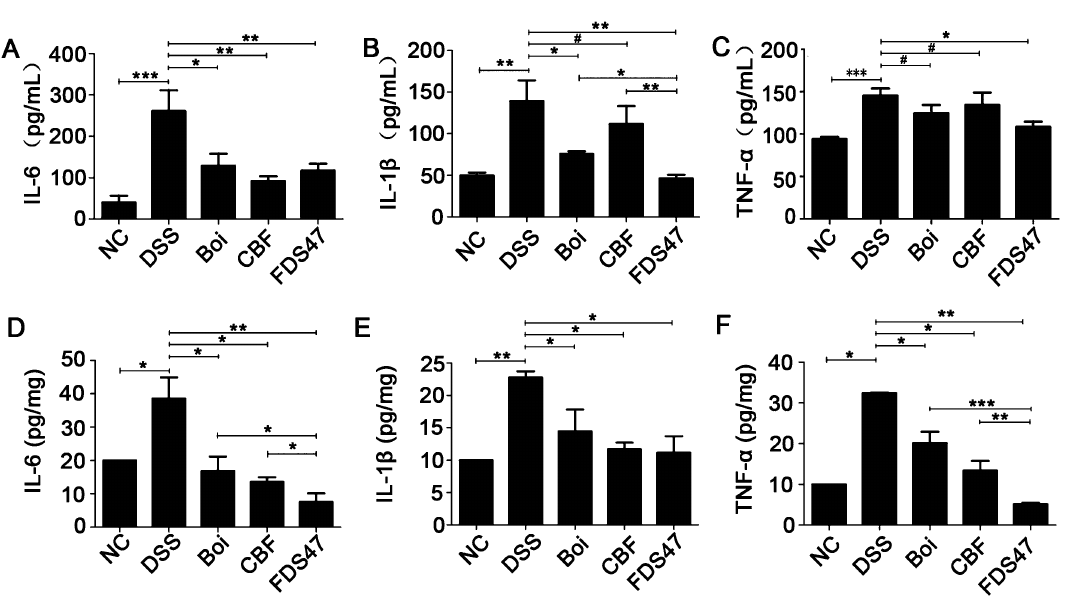
Figure 6. Effects of Boi, CBF or FDS47 on the levels of inflammatory cytokines in mice. Boi (boiled), CBF (compound bacterium fluid) and FDS47 (fermented Danshen sequence 47). The levels of IL-6 ( A ), IL-1β ( B ) and TNF-α ( C ) in serum of DSS- induced UC mice were detected using ELISA Kits. The levels of IL-6 ( D ), IL-1β (E) and TNF-α (F) in the colonic homogenate of DSS-induced UC mice were detected using ELISA Kits. All groups (NC, Boi., CBF, FDS47) were statistically analyzed with the DSS group. The FDS47 group and other groups (Boi., CBF) were statistically analyzed from group to group. (Data are expressed as means ± S.E. # p > 0.05, * p < 0.05, ** p < 0.01 and *** p <